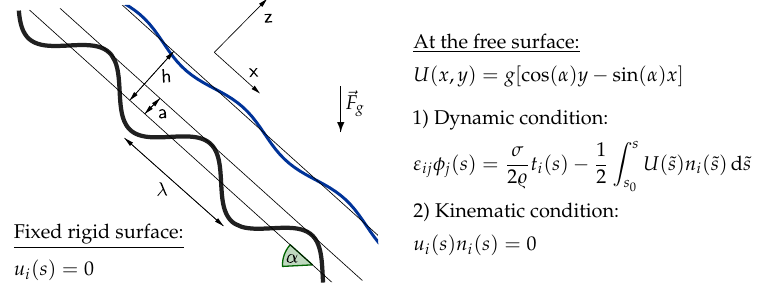
Figure 4. Schematic of gravity-driven film flow down a corrugated rigid surface inclined at an angle α to the horizontal. The indices i and j in the boundary conditions run from 1 to 2.